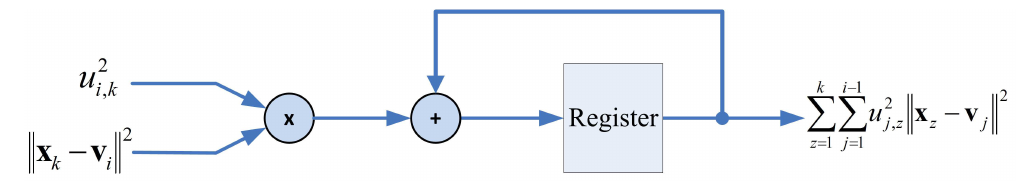
Figure 7. The architecture of cost function computation